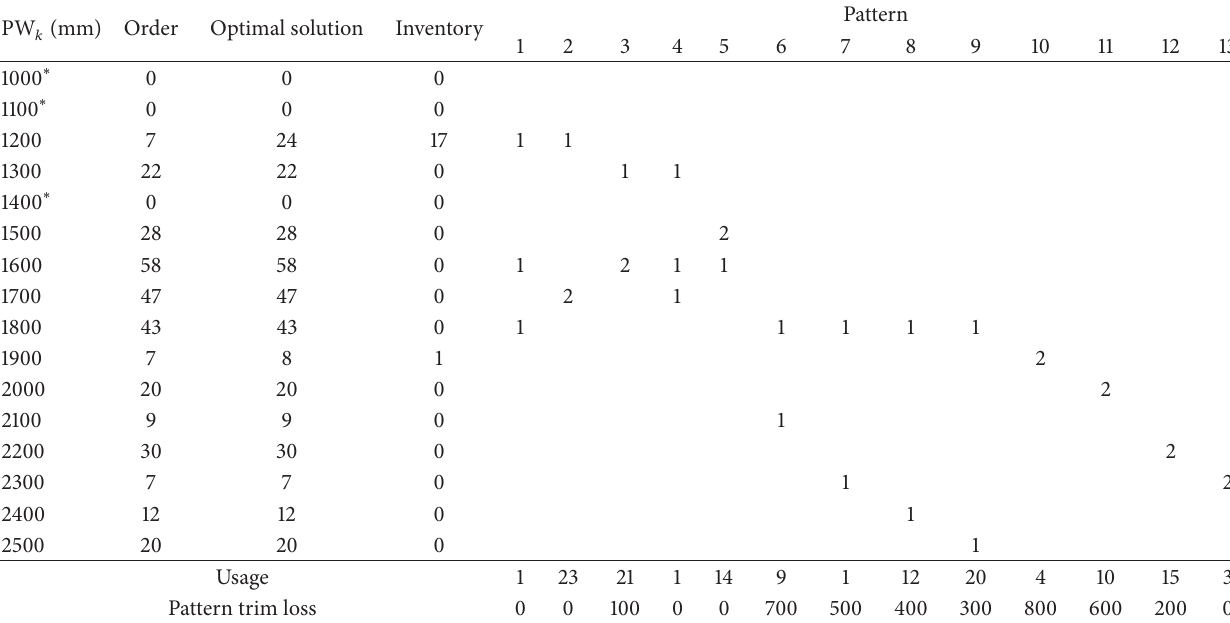
Table 7: The results of a traditional CSP